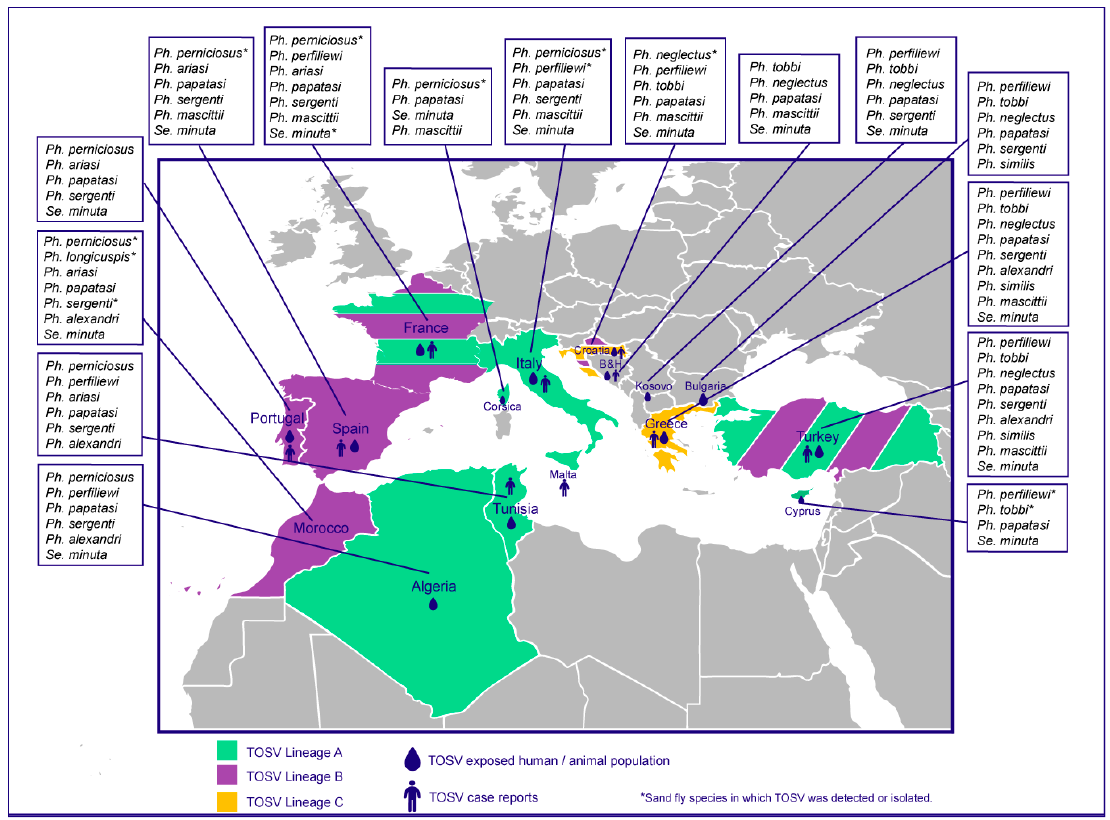
Figure 2. Geographical distribution of Toscana virus (TOSV) and reported distribution of predominant sand fly species in the countries where TOSV is